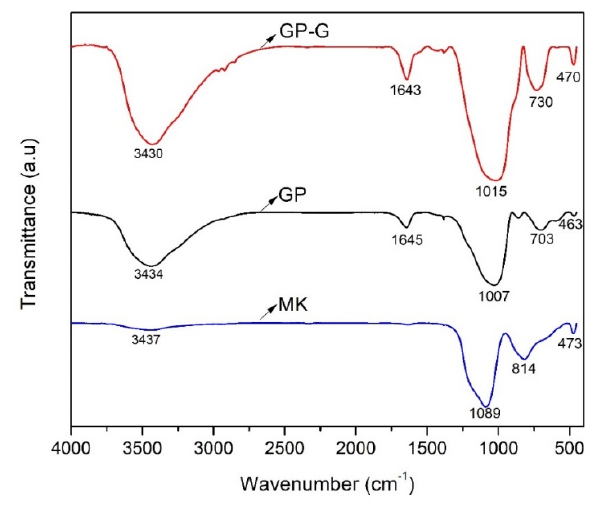
Figure 6. Fourier-transform infrared (FTIR) spectra obtained for MK, GP, and GP-G. Figure 6. Fourier ‐ transform infrared (FTIR) spectra obtained for MK, GP, and GP ‐ G.